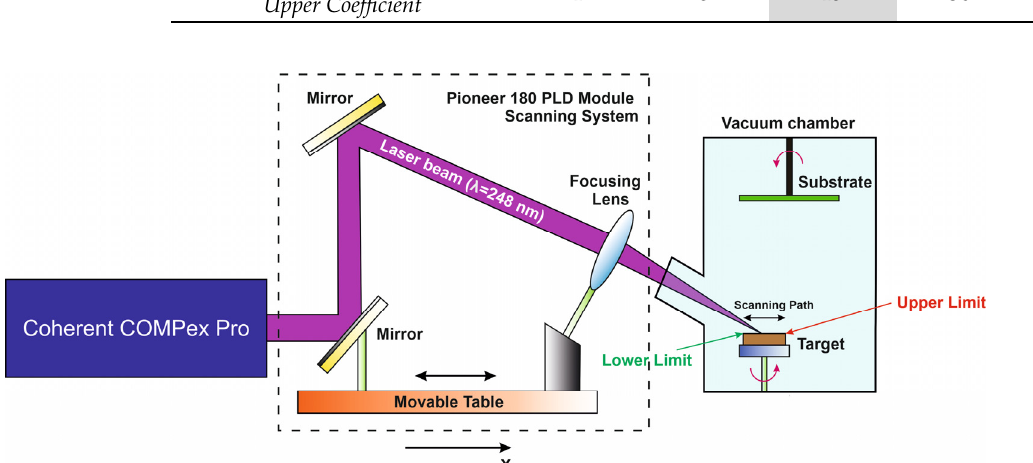
Figure 1. Laser beam scanning of the target surface in the Pioneer 180 PLD module. The Upper Limit and Lower Limit parameters are the lower and upper limits of the laser beam movement and allow localizing the area of action of the laser beam on the target surface by a segment ( Lower Limit , Upper Limit ). The point in this segment at which the irradiation process starts is determined by the Origin parameter. Values of all of the aforementioned parameters lie within [0, 2 R ], where R —target radius. The Max Velocity and Min Velocity parameters determine the maximum and minimum speed of movement of the laser beam on the target surface. Near the point defined by the Origin parameter, the scanning speed varies within ( Min Velocity , Max Velocity ). On the ( Origin , Upper Limit ) section, the change in scanning speed is determined by the Upper Coefficient parameter, and on the ( Lower Limit , Origin ) section by the Lower Coefficient parameter. The speed of scanning system movement is described by two functions that intersect at a point with a coordinate defined by the Origin parameter. The relationship between the functions is described by the